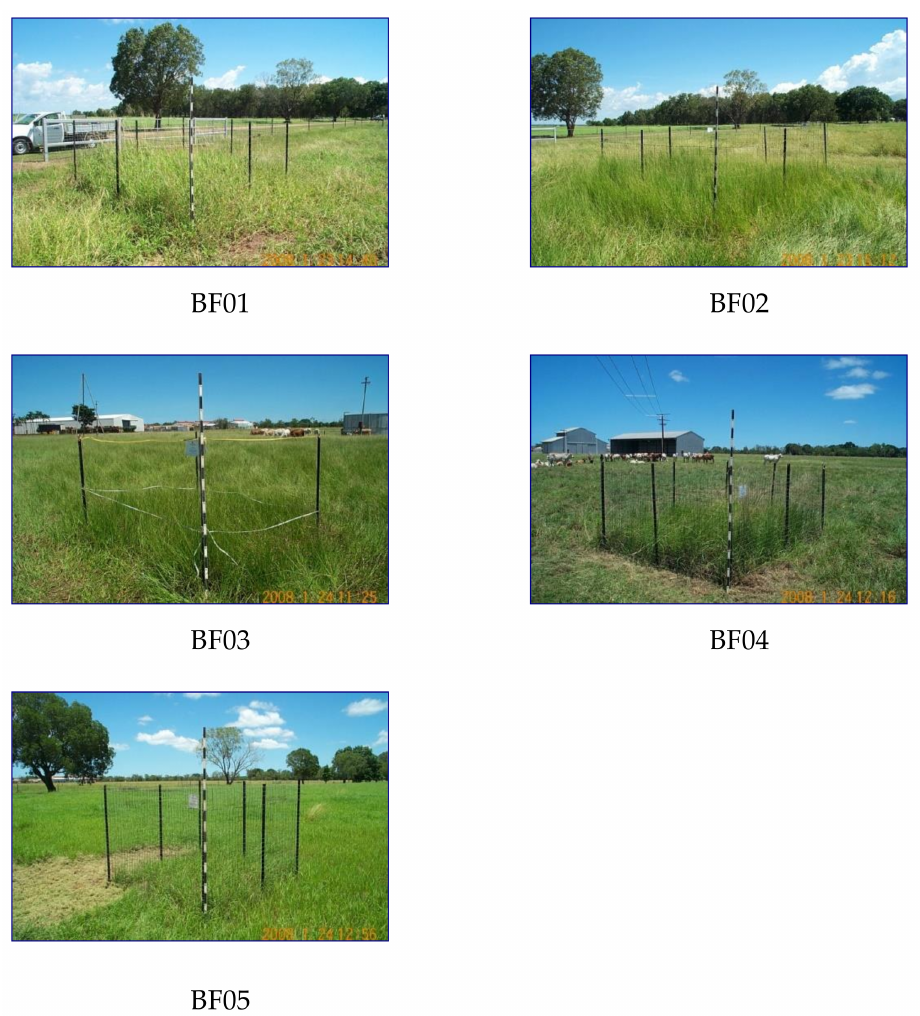
Figure 3. The grass plots at Berrimah Farm (BF) (taken 23_01_2008). Plots BF01, BF04 and BF05 were of the same genus, Digitaria , with similar species/varieties and plots BF02 and BF03 were of the same species, Brachiaria humidicola